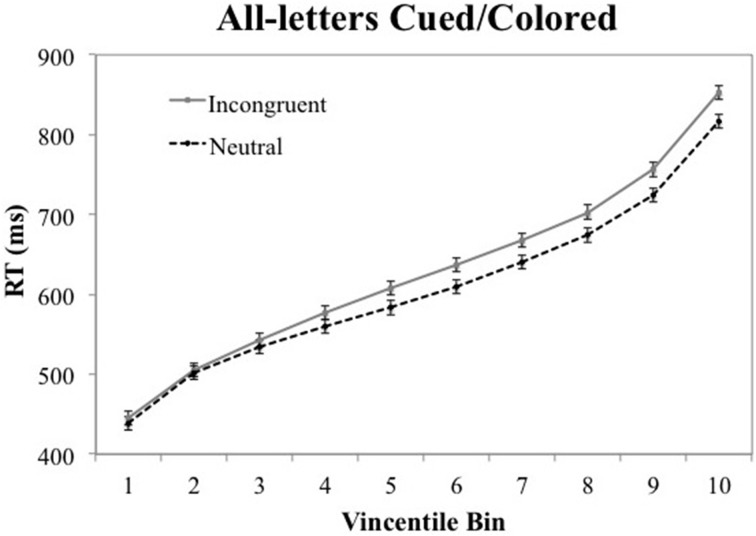
Vincentile RT means for incongruent (i.e., color-associated) vs. neutral stimuli in the all-letters cued/colored condition with 95% confidence intervals.